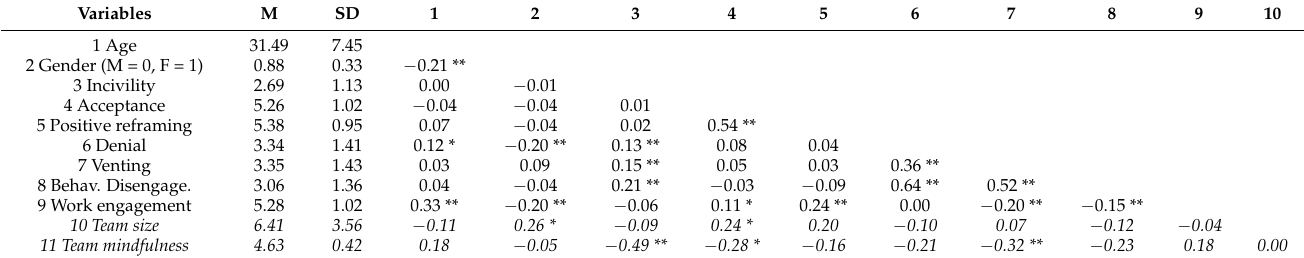
Figure 1. Hypotheses tested in the study. Table 1. Descriptive statistics and